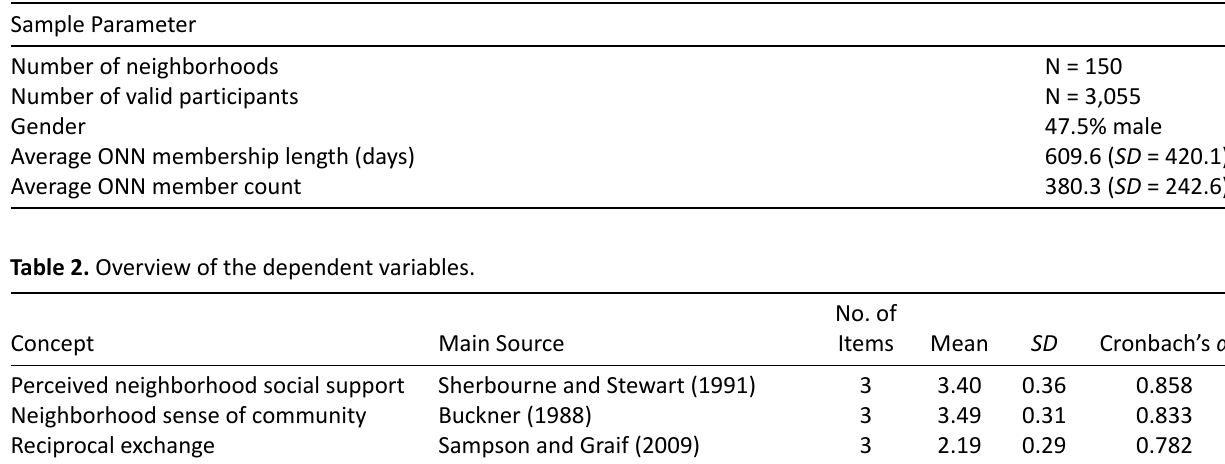
Table 1. Sample description.